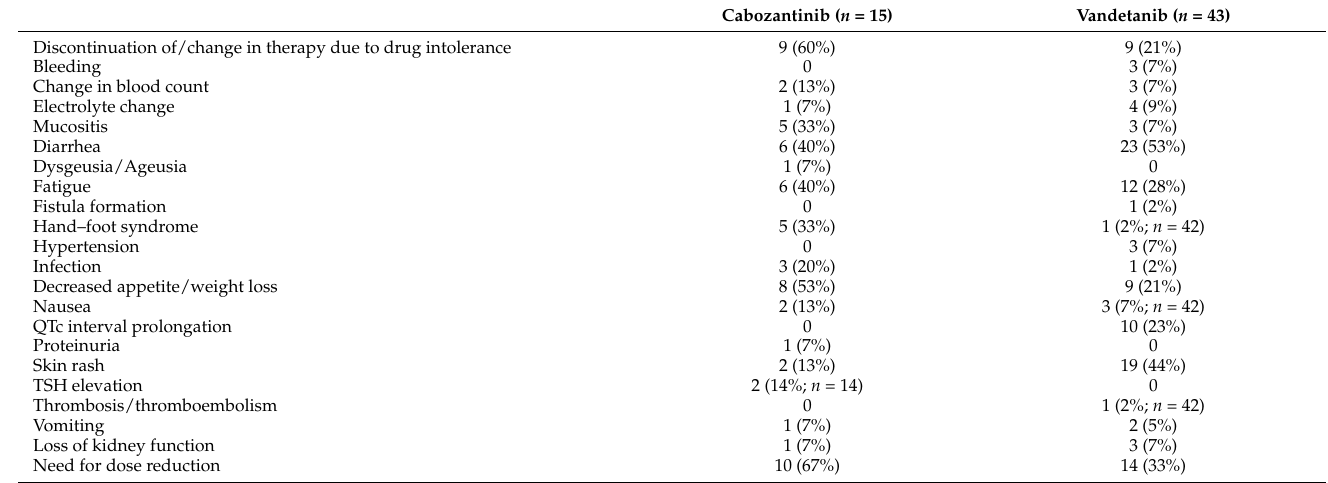
Table 3. TEAEs in patients with RET -positive MTC treated with vandetanib and/or